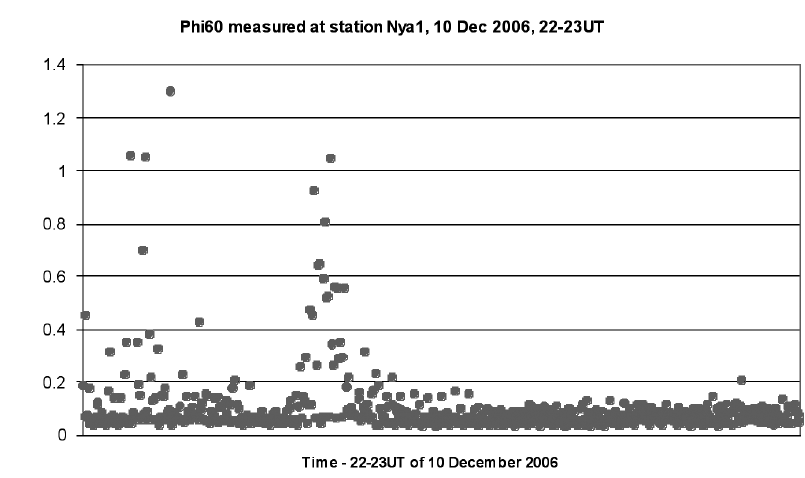
Fig. 20. Values of Phi60 between 22-23UT at station Nya1 on 10 Dec 2006.